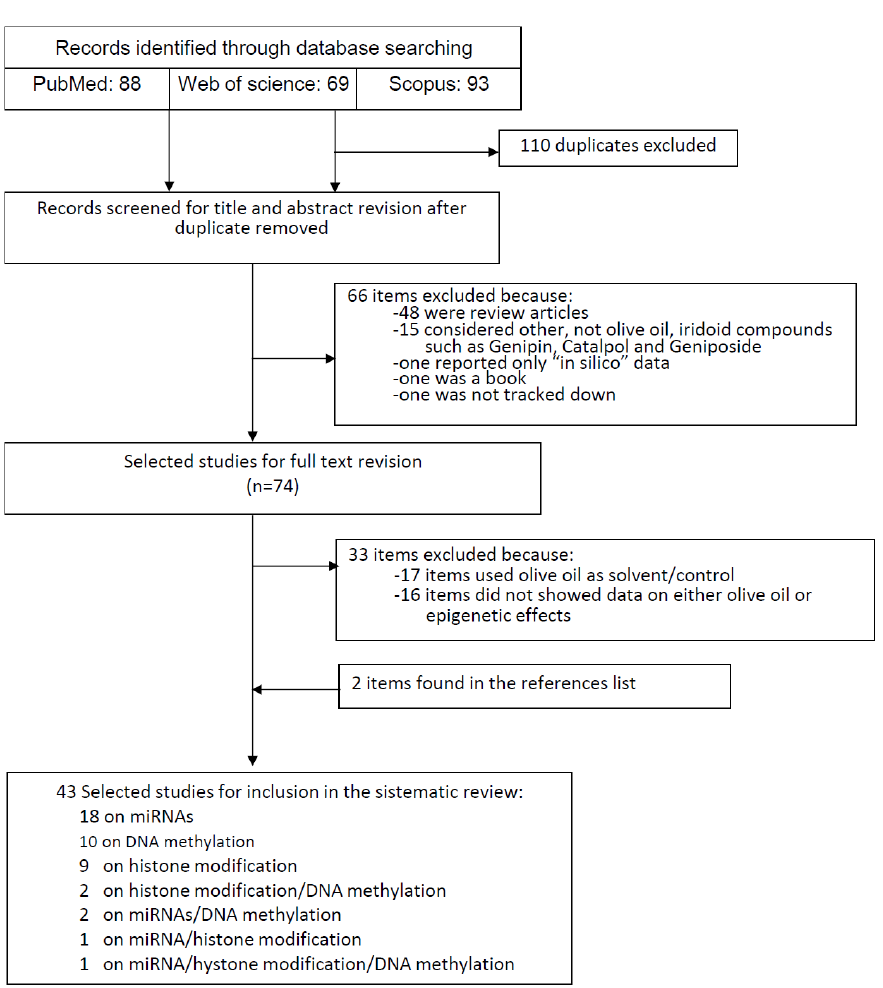
Figure 1. Flow diagram of study selection process.